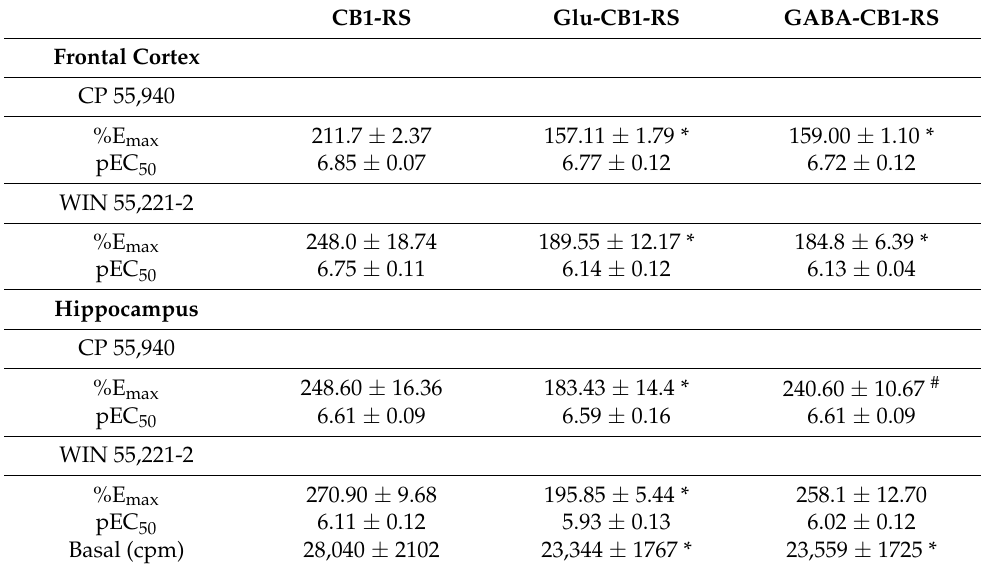
Table 1. Concentration–response curves for agonist-stimulated specific [ 35 S]GTP γ S binding in frontal cortical and hippocampal synaptosomes derived from CB1-RS, Glu-CB1-RS, and GABA-CB1-RS mice. Values correspond to the means ± SEM of three independent experiments. Both in frontal cortex and hippocampus the experiments were carried out using two preparations enriched in synaptosomes, each of them obtained from pools of the frontal cortices and hippocampi of eight adult mice. Unpaired (%E max ) or paired (pEC 50 , Basal) one-way ANOVA followed by sidak test.